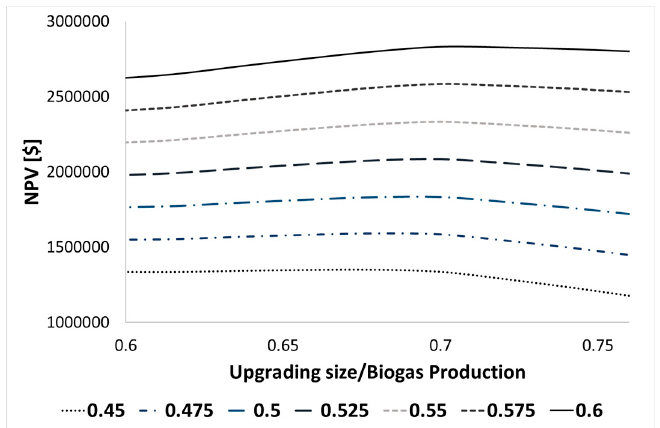
Figure 19. The net present value (NPV) after 20 years as a function of the ratio between the upgrading size and the total biogas production, for various bio-methane selling prices ($/m 3 ).